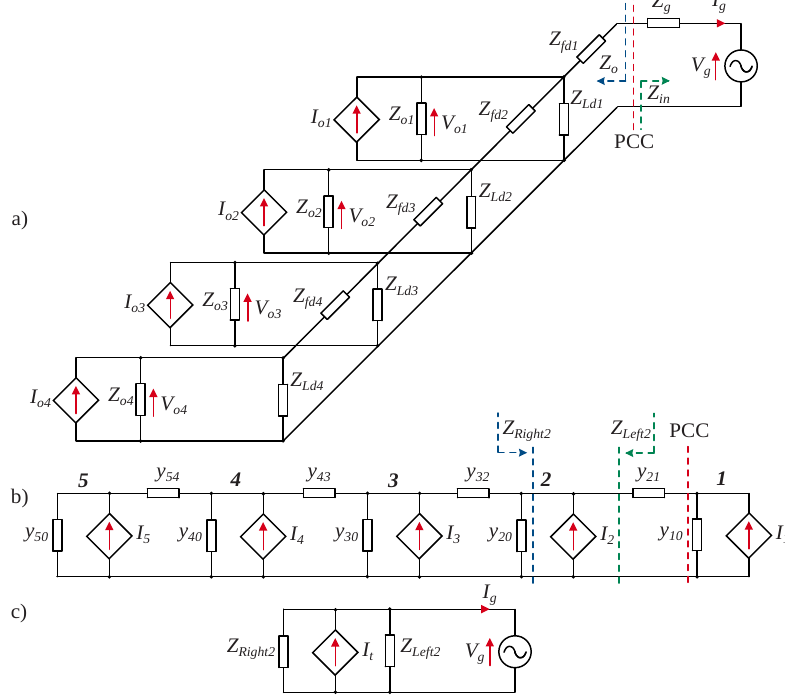
Figure 11. Impedance model representation of a distributed system with multiple connected inverter systems: ( a ) physical connection, ( b ) impedance, and ( c ) equivalent resonant models.